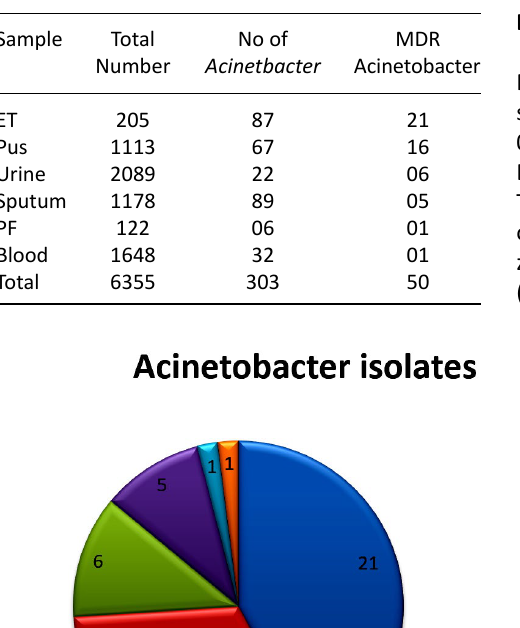
Table 1. Total number of isolates obtained from different samples.